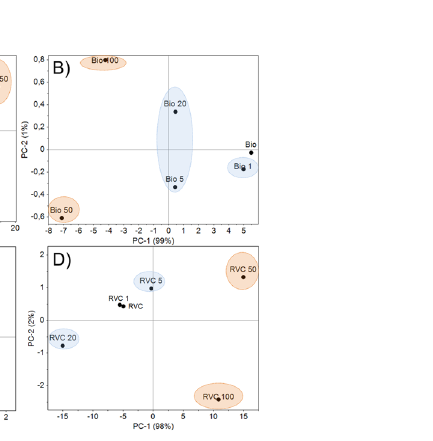
Fig 4. PCA of FTIR Pure Spectra of Materials with and without Various Levels of Retained Cd 2+